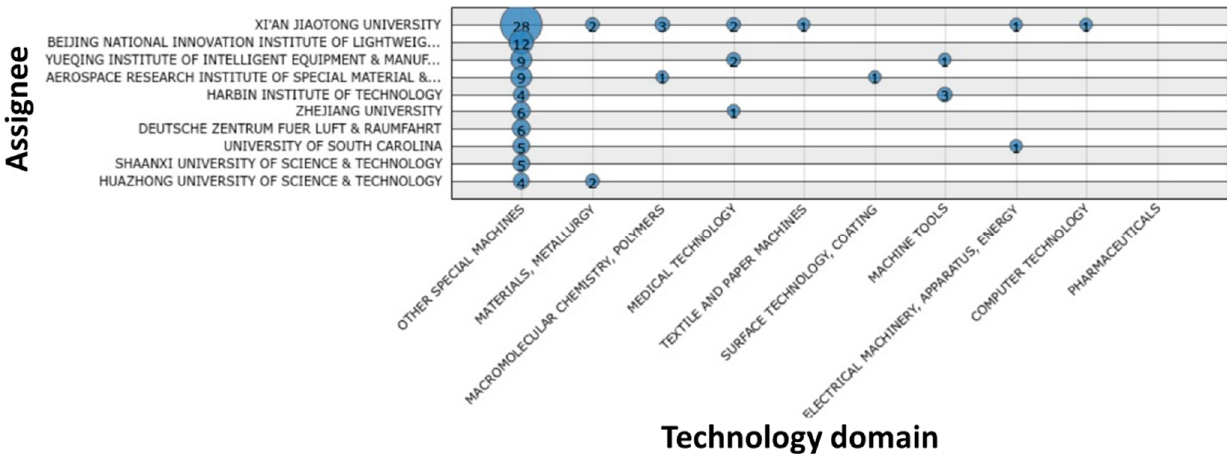
Figure 16. Count of patent families for the 20 largest institutional assignees in FFF adapted to CFRTPC printing in February 2021.